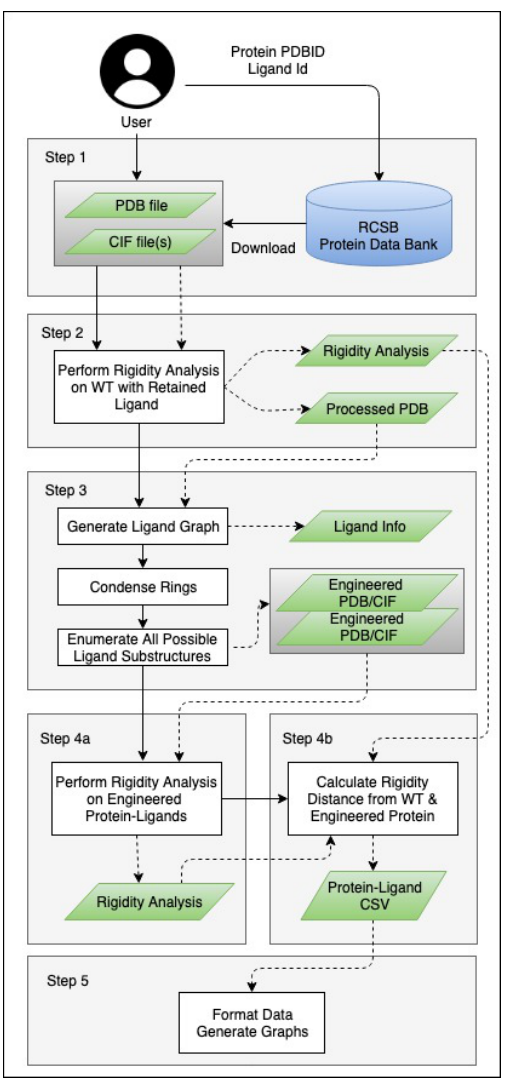
Figure 2. P rotein-Ligand complex E ngineering T hrough R igidity A nalysis (PETRA) compute pipeline. Dotted lines specify data; solid lines specify control